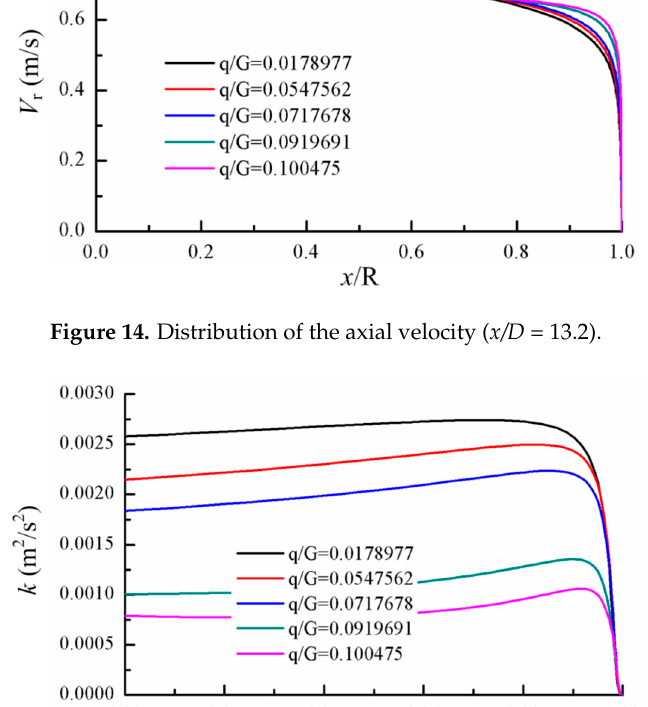
Figure 15. Distribution of the turbulent kinetic energy ( x/D = 13.2).